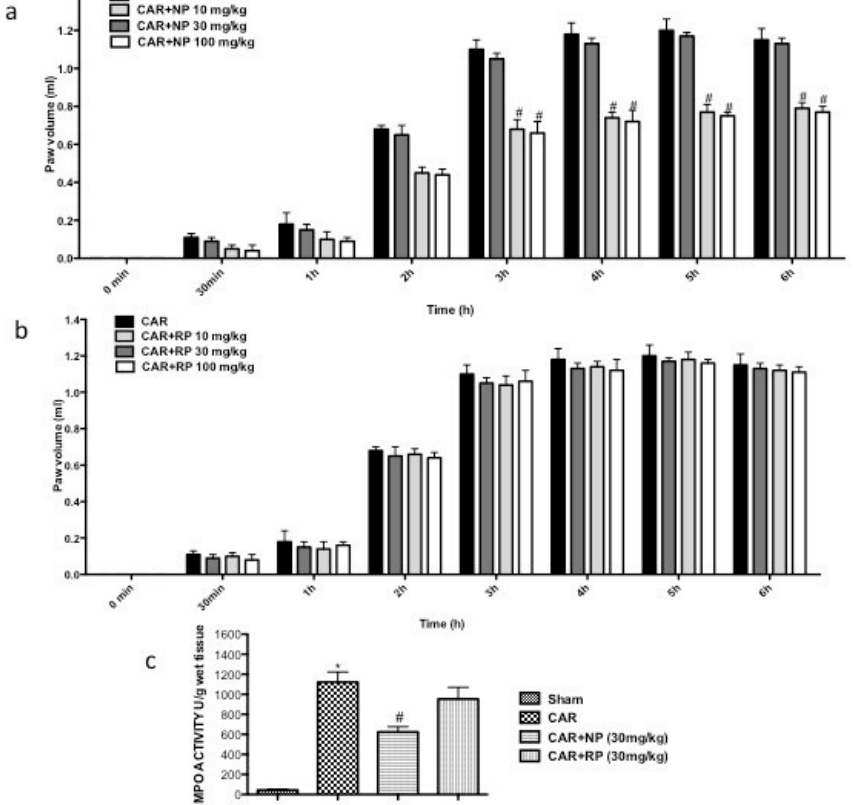
Figure 5. Effect of NP and RP on the time course of carrageenan-induced paw edema. NP and RP were administered orally 30 min before CAR injection. Paw edema was assessed at the time points indicated ( a , b ). NP produced significant improvements in the paw edema (measured as paw volume) in comparison to RP administered at the same time point and at the same doses. Moreover, we observed increased levels of MPO after CAR injections and treatments with NP, but no RP significantly reduced levels of MPO ( c ). Values are means ± SEM. * p < 0.05 vs. Sham; # p < 0.05 vs.